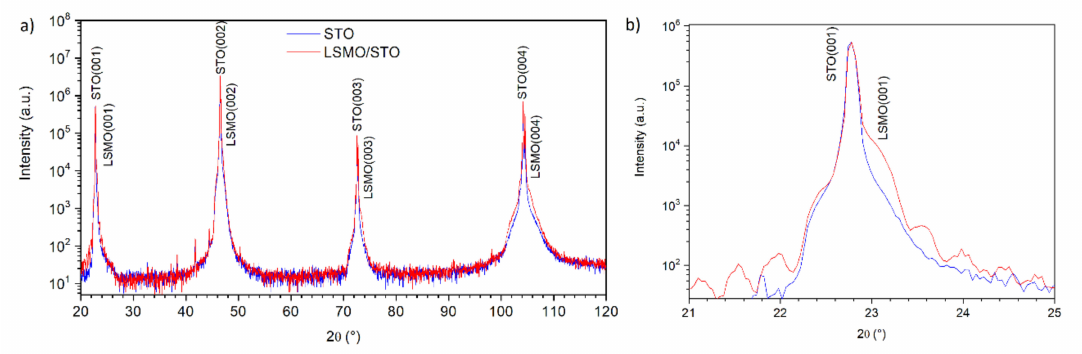
Figure 4. ( a ) The XRD measurement of the STO substrate prepared by “bu ff er” method (blue) and the same sample after LSMO deposition (red). ( b ) Close-up on (100) reflex